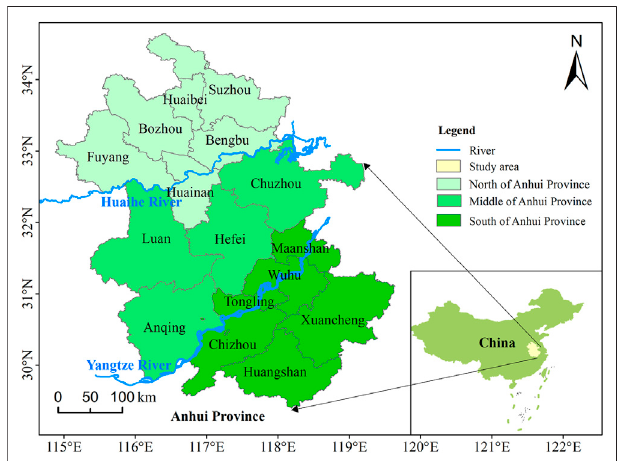
FIGURE3| ThegeographiclocationofAnhuiprovinceanditssubregion